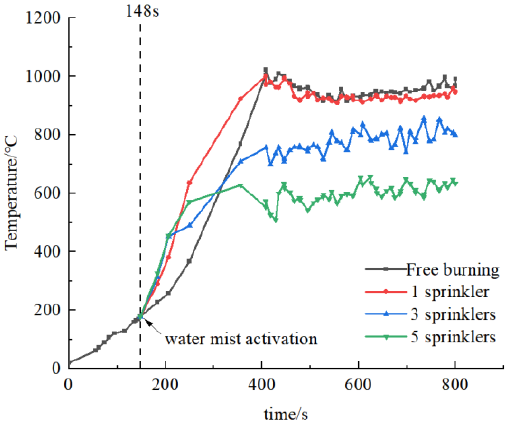
Figure 6. Temperatures measured by thermocouple A at different nozzle densities.